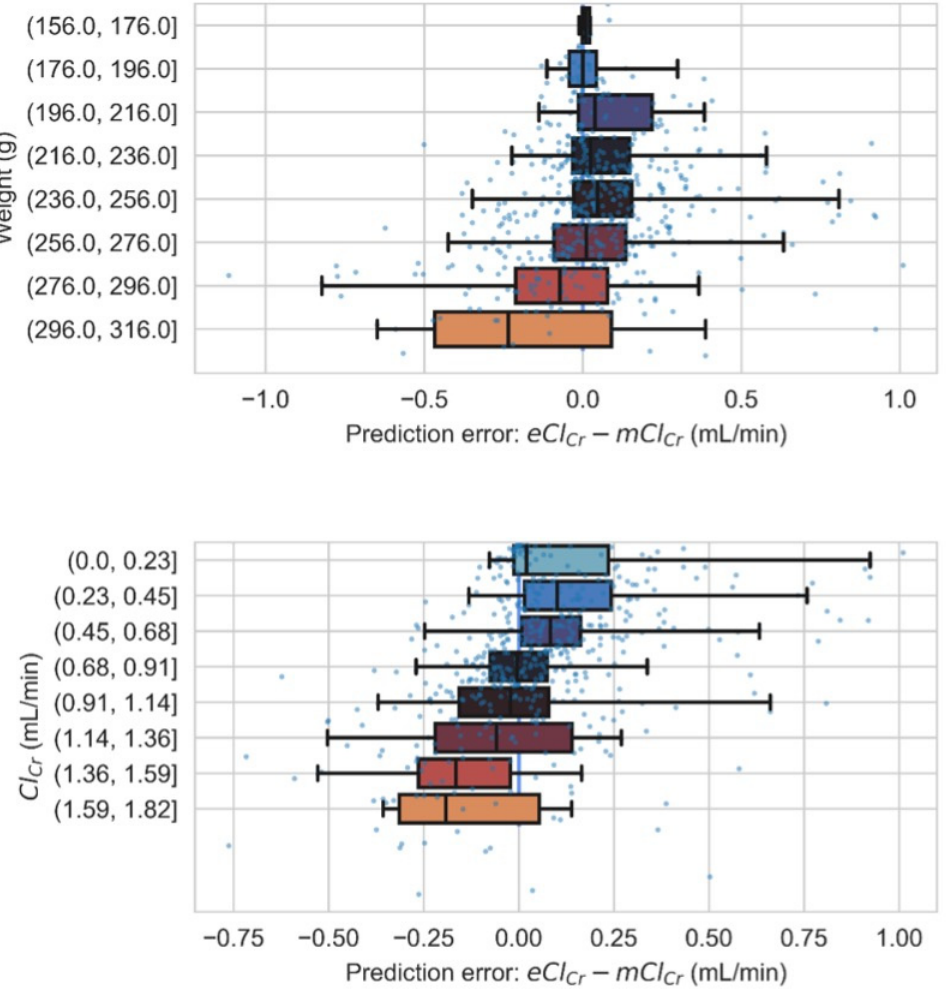
Figure 4. Prediction error analysis. Prediction error box plots according to the rat’s body weight range ( top ) and the mClCr range ( bottom ). Error bars represent the 2.5th and 97.5th percentiles. A scatter plot of prediction errors is also shown superimposed.